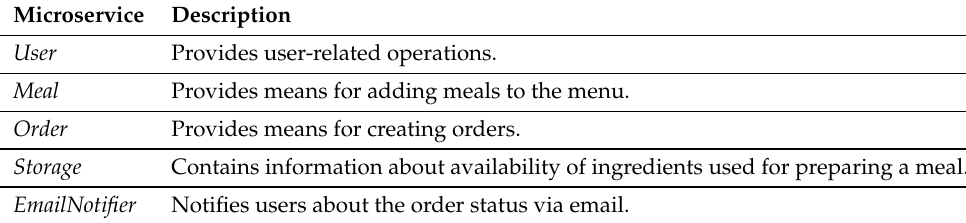
Table 10. Microservices that compose Eat and Drink application and their